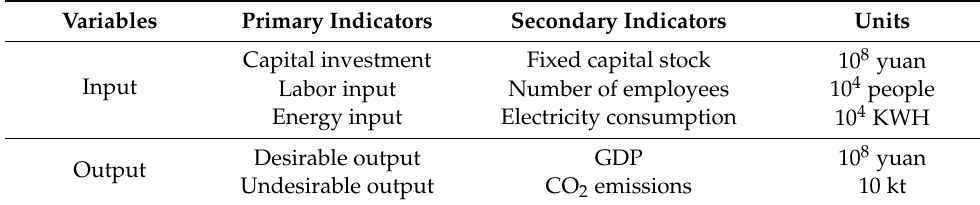
Table 1. Socio-demographic profile of the respondents. Variables Primary Indicators Secondary